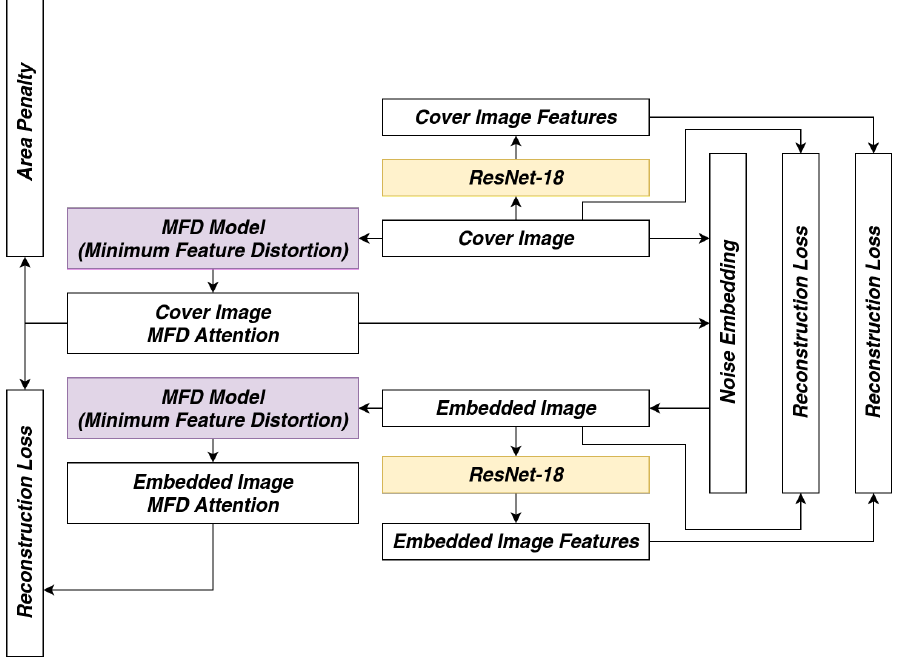
Figure 11. MFD attention mechanism training